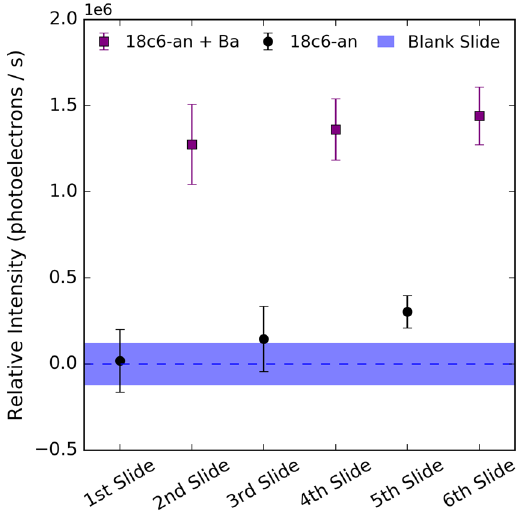
Figure 8. Measured response of dry barium-chelated vs. unchelated microscope slides excited at 365 nm under fluorescence microscope. Each error bar represents the 1 σ spread if intensities within a single slide, and each point represents an independently prepared slide. A clear enhancement of the “on” state relative to the “off” state is visible.